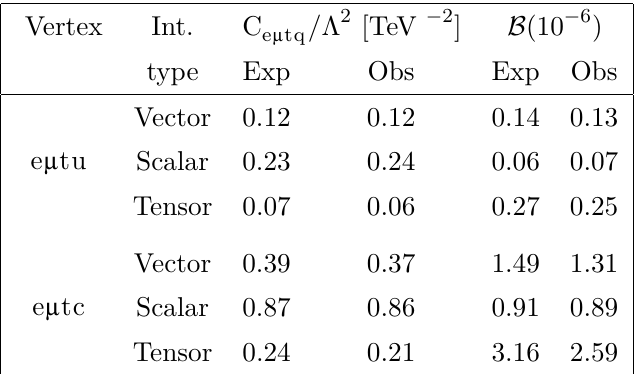
Table 4 . Expected and observed 95% CL upper limits on the CLFV Wilson coefficients and top quark CLFV branching fractions.